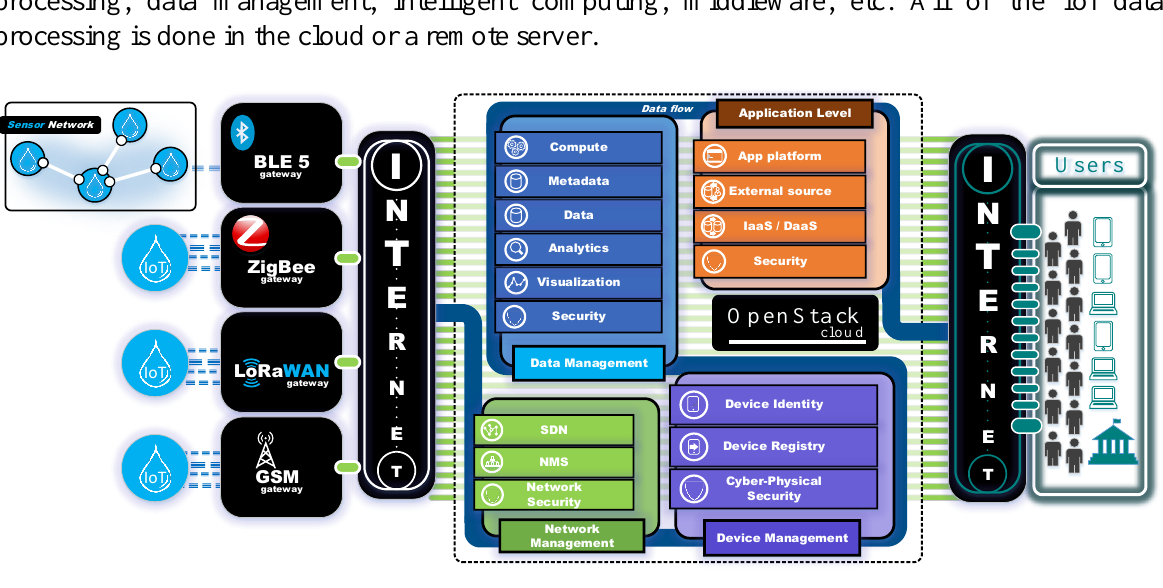
Figure 5. The SmartWater architecture